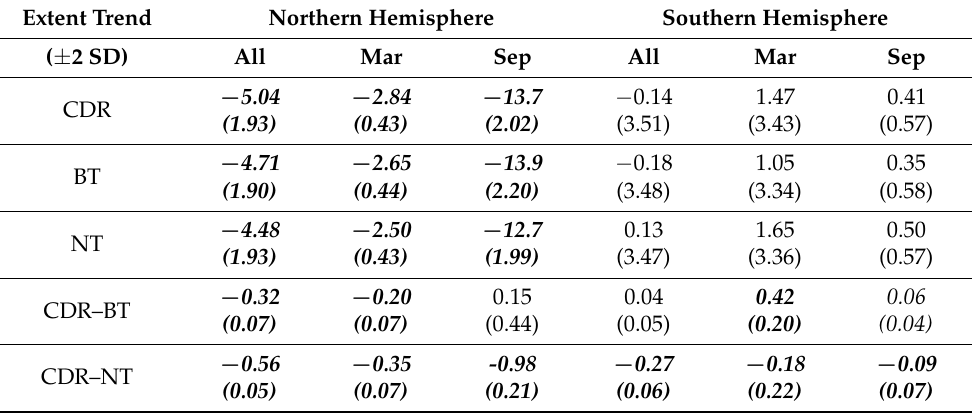
Table 1. Monthly extent linear trends, in % per decade relative to the 1981–2010 CDR climatology, for both hemispheres for the entire timeseries and for March and September. The difference trends are calculated from monthly differences between CDR and BT or NT. The 2 standard deviation range of the trend is given in parentheses below each trend value. Statistically significant trends ( p < 0.05) are in italics